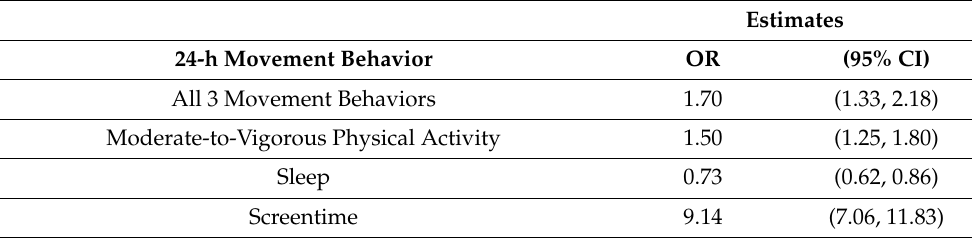
Table 2. Odds of meeting the movement behavior guidelines while attending in-person compared to virtual school for elementary-age children during the same 14-day measurement period in October or